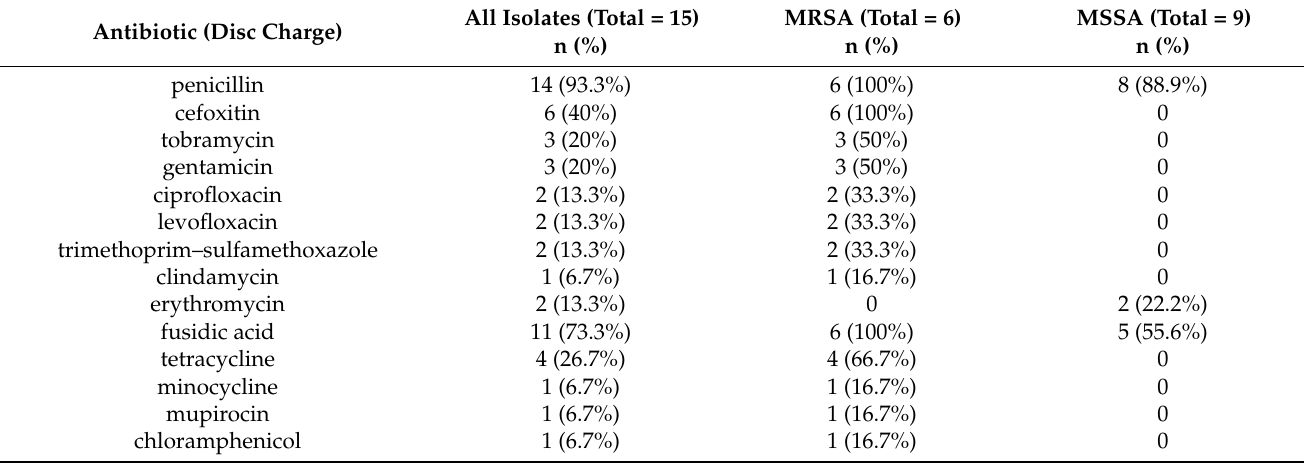
Table 2. Antibiotic resistance rate of the 15 S. aureus isolates from DFIs. Antibiotic (Disc